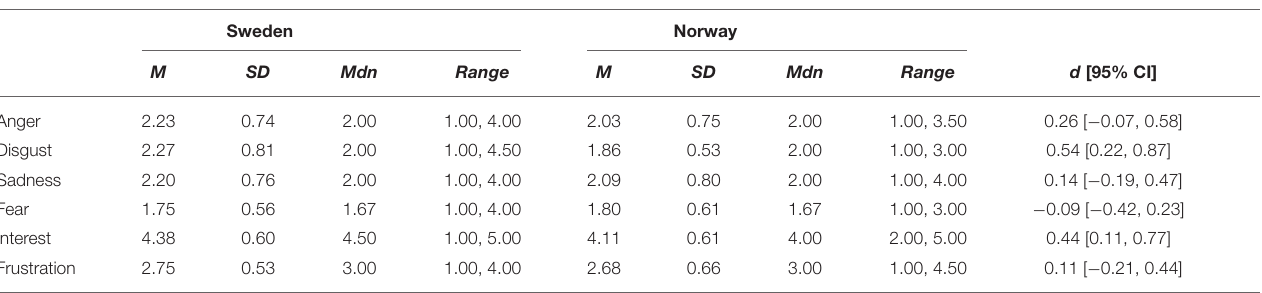
TABLE 4 | Descriptive statistics and sample differences for reported experienced emotions.